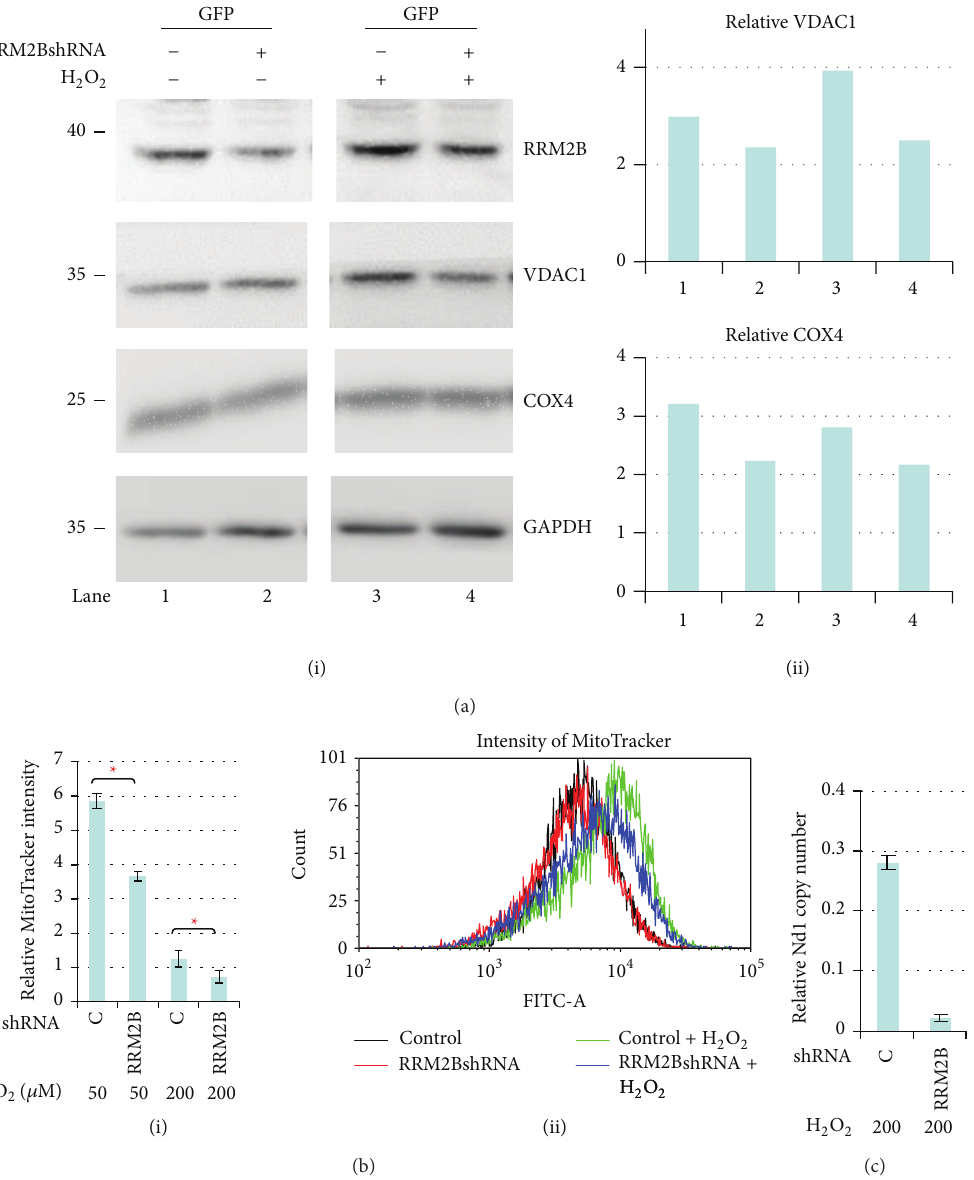
Figure 3: RRM2B impacts on mitochondrial homeostasis through regulating mitochondrial genes and copy number under oxidative stress. (a) Cells were treated with H 2 O 2 and harvested for Western blot analysis using RRM2B and mitochondrial proteins VDAC1 and COX4 antibodies. GAPDH served as control. Image J was used to normalize VDAC1 and COX4 expression relative to GAPDH, and the normalized figures were shown in 3(a)(ii). (b)(i) H1299 stable cells treated with indicated concentrations of H 2 O 2 were harvested 24 hours later for FACS analysis. The detection of MitoTracker was described in Section 2. The intensity of the MitoTracker Green signal relative to untreated control cells is shown here (means ± SEM, 𝑛 = 2 ). (b)(ii) Cells were treated with H 2 O 2 and harvested at 24-hour time point and underwent FACS analysis. MitoTracker Green probe was used for cell staining, and this figure shows the MitoTracker intensity of the representative data from (b)(i). (c) Cells were treated with 200 𝜇 M H 2 O 2 and harvested 24 hours later for Q-PCR analysis. Expression of normalized Nd1 relative to untreated control cells is shown (means ± SEM, 𝑛 = 2